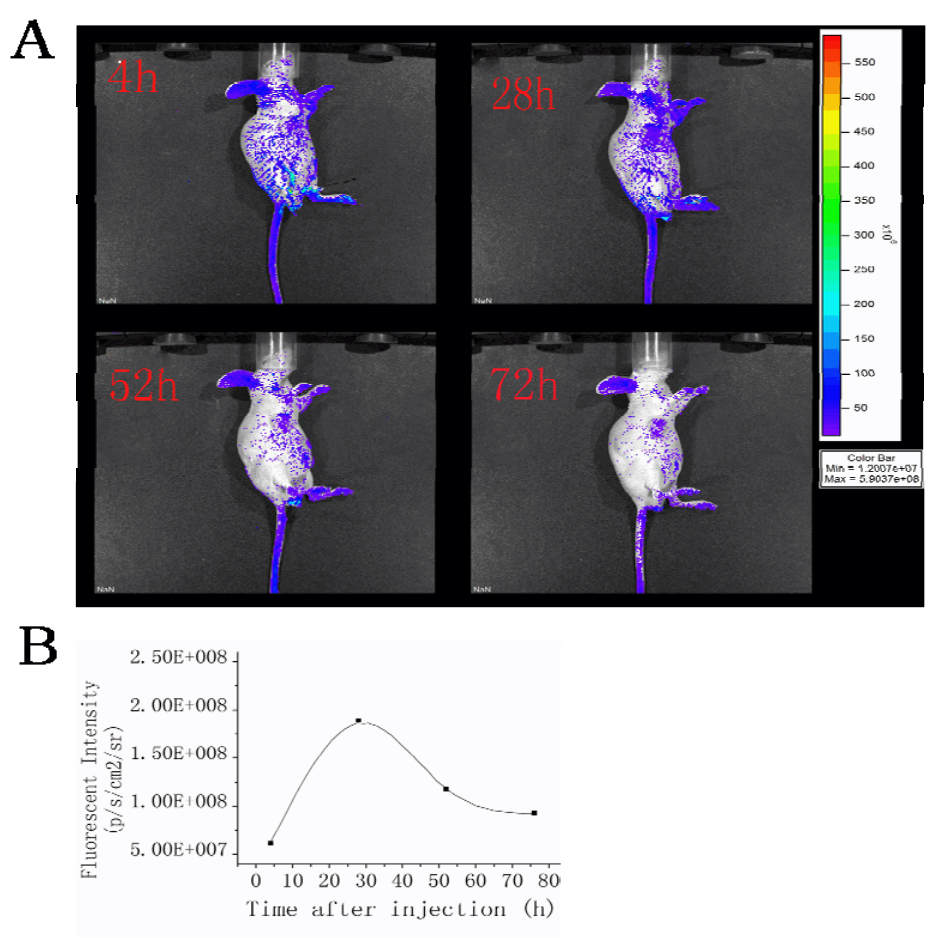
Figure 3. ( A ) Fluorescence images of MFC-7 tumor mice in real time postinjection of folate-TO. ( B ) Fluorescent intensities at different injection